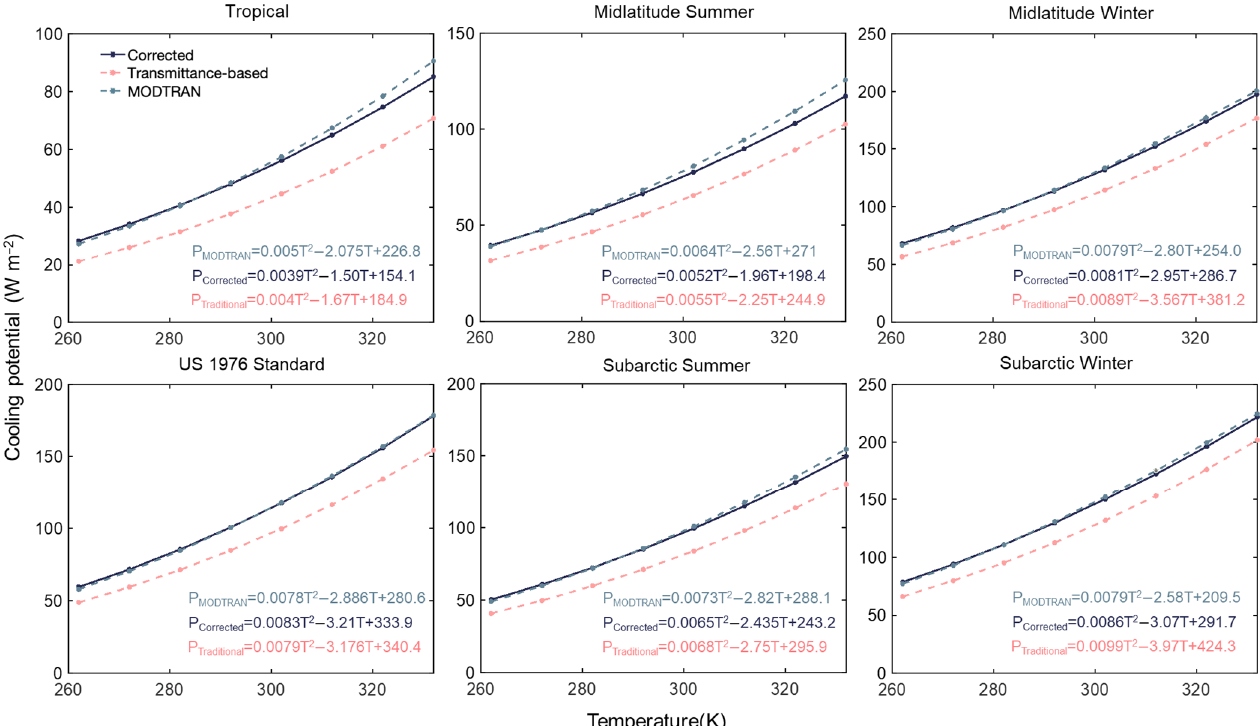
Figure 4. Maximum cooling potential ( P cooling = I BB ( T amb ) − I atm ) calculated using the traditional transmittance-based model, the corrected model and MODTRAN for the six standard atmospheric profiles, but with T amb varied from 262 to 332 K. Dots indicate the calculated data, and the lines indicate fits with R 2 > 0.99. Equations for the fits are provided. The data at low temperatures for the Tropical, Midlatitude Summer and Subarctic summer atmospheric profiles should be used with caution because at such temperatures, the atmosphere does not typically hold the high TPW levels that characterize the standard cases.